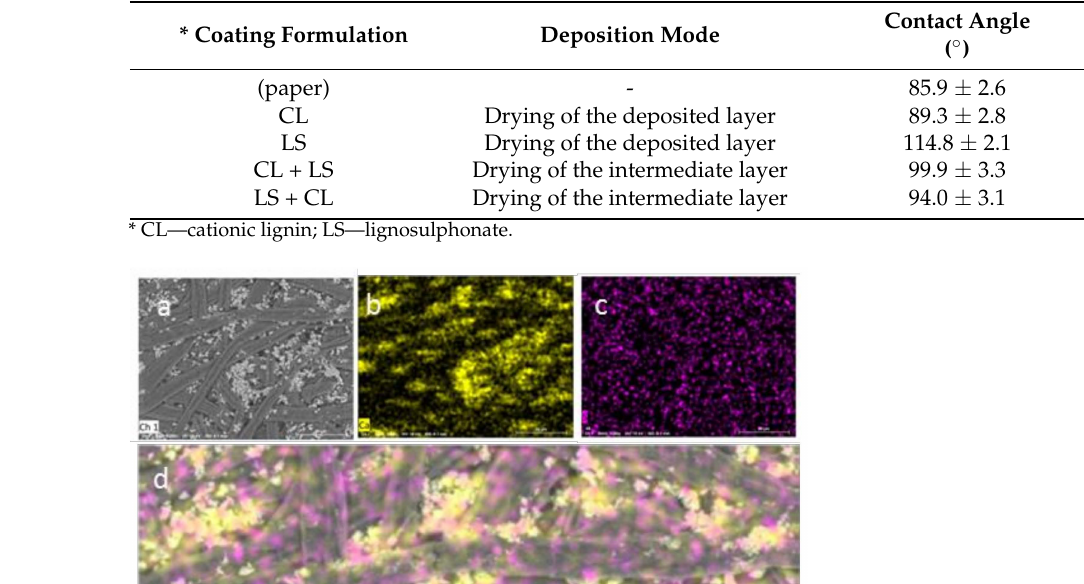
Table 3. Water contact angles of industrial printing paper coated with lignin formulations.